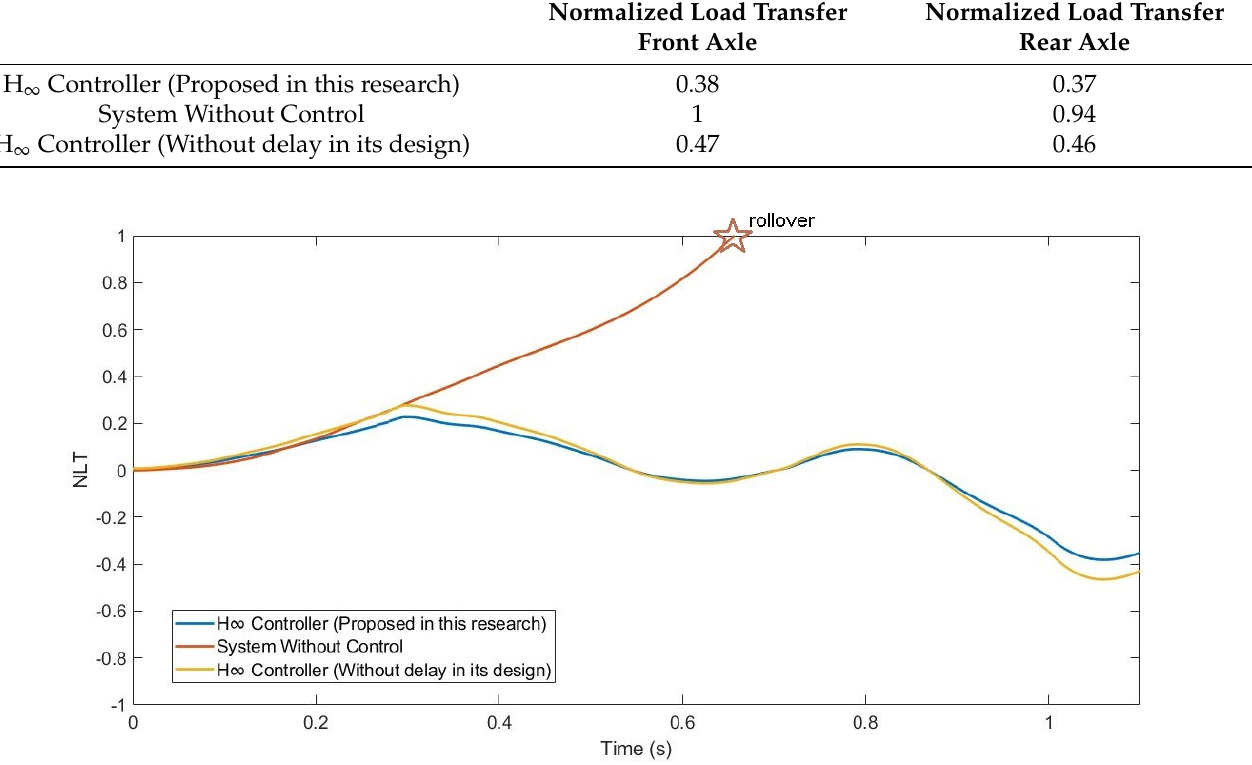
Figure 23. NLT of front axle for test 3: Roundabout at 120 km/h.